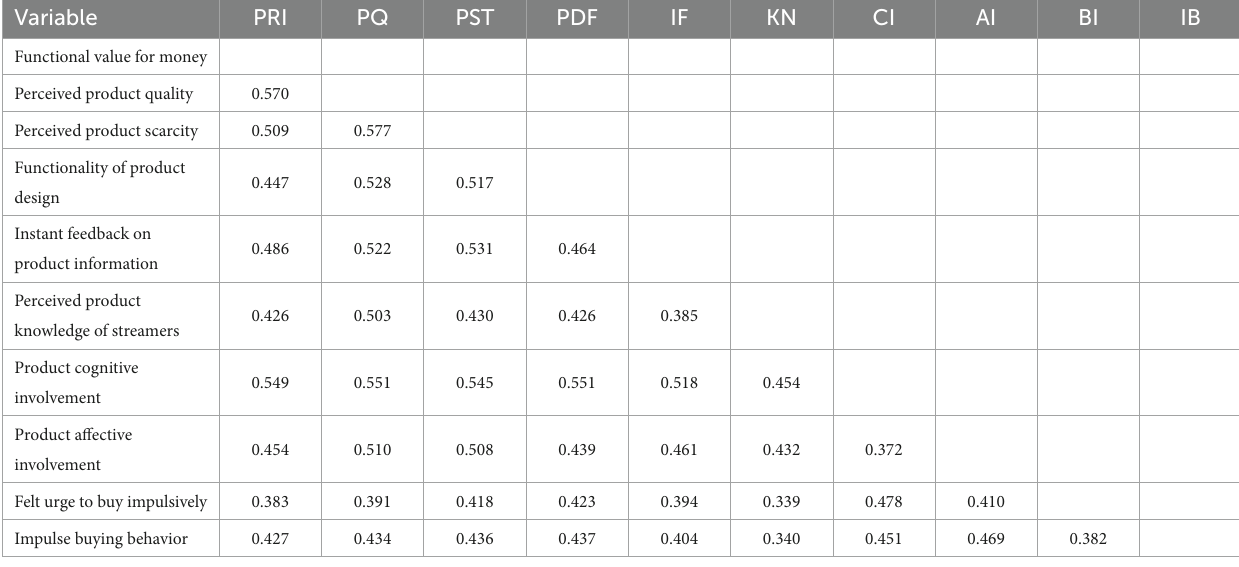
TABLE 5 HTMT ratio estimates.